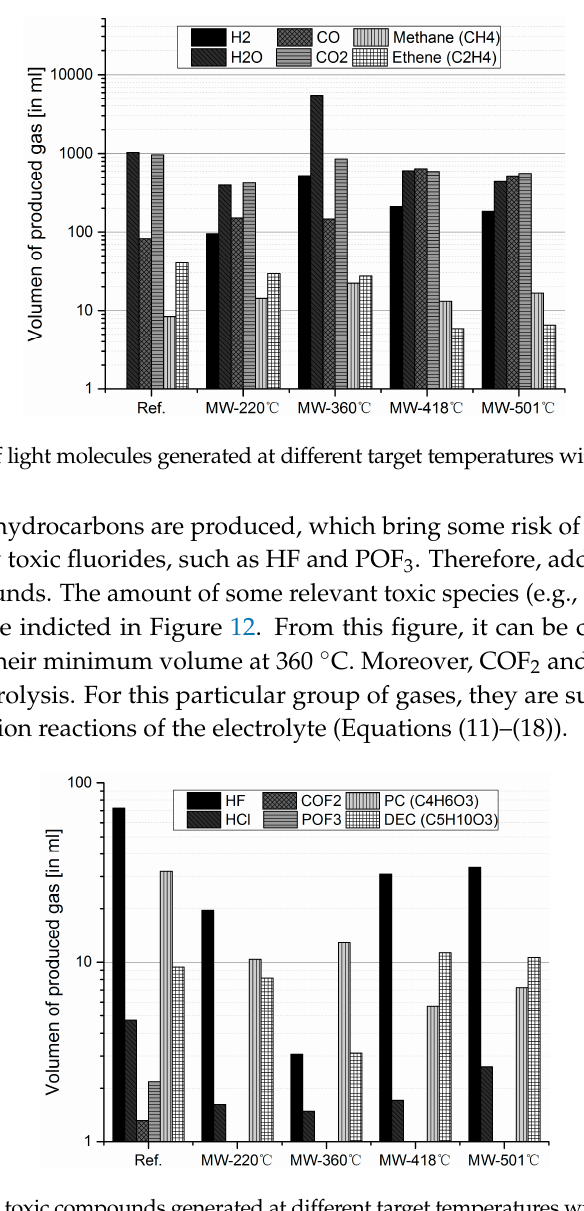
Figure 12. Volume of toxic compounds generated at different target temperatures with microwave heating.